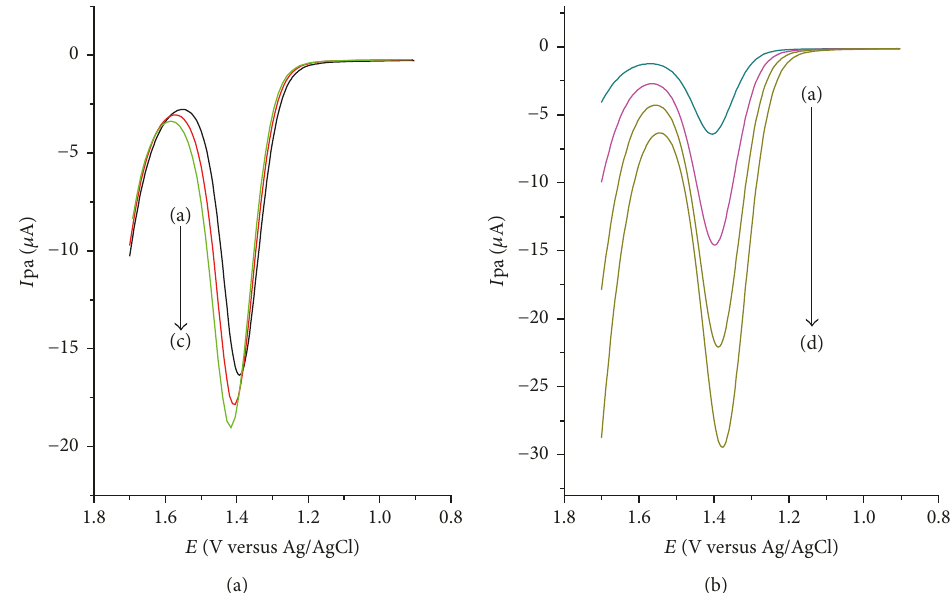
Figure 5: DPVs of lignin modified GCE in pH 4 ABS containing 1mM caffeine at (a) different step potentials ((a)–(c): 4, 8, and 12mV, resp.) and pulse amplitude of 50 mV and (b) different amplitudes ((a)–(d): 25, 50, 75, and 100 mV, resp.) and step potential of 8mV.